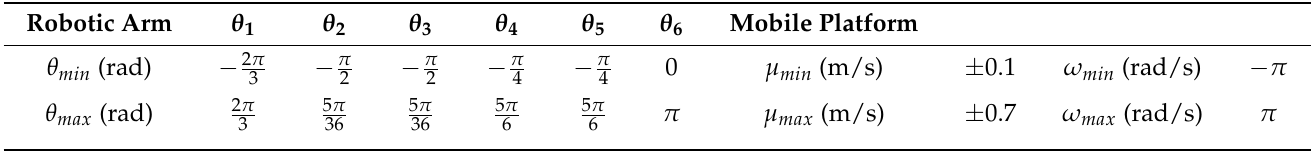
Table 4. Analysis of the workspace of a mobile manipulator based on the Monte Carlo method. Upper and lower rotation limits of the mobile manipulator joints. Robotic